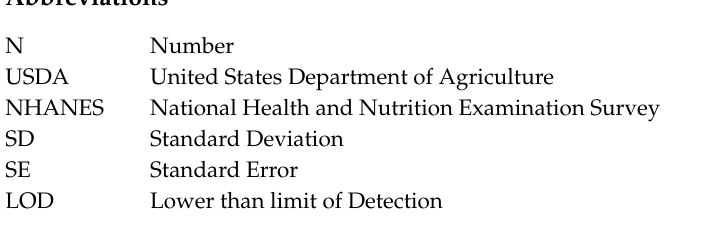
Table S1: Original and Harmonized Response-Levels for TDID and S / H Cohorts, Table S2: Comparison of the demographic characteristics of TDID participants included and not included in the study, Table S3: Pesticide exposure descriptive statistics in NHANES 2001–2002 and 2009–2010 among Females, Figure S1: Comparison of Geometric mean of pesticides in two